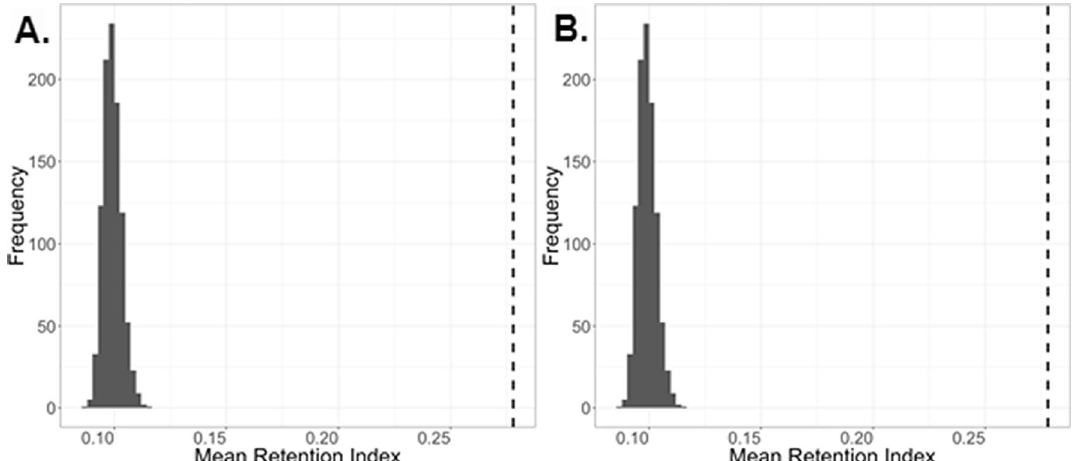
Figure 3. ( A ) The mean retention index for 1000 random permutations in Mammalia, and ( B ) The mean retention index for 1000 random permutations in non-mammalian vertebrates. The actual mean retention index is represented with the dashed